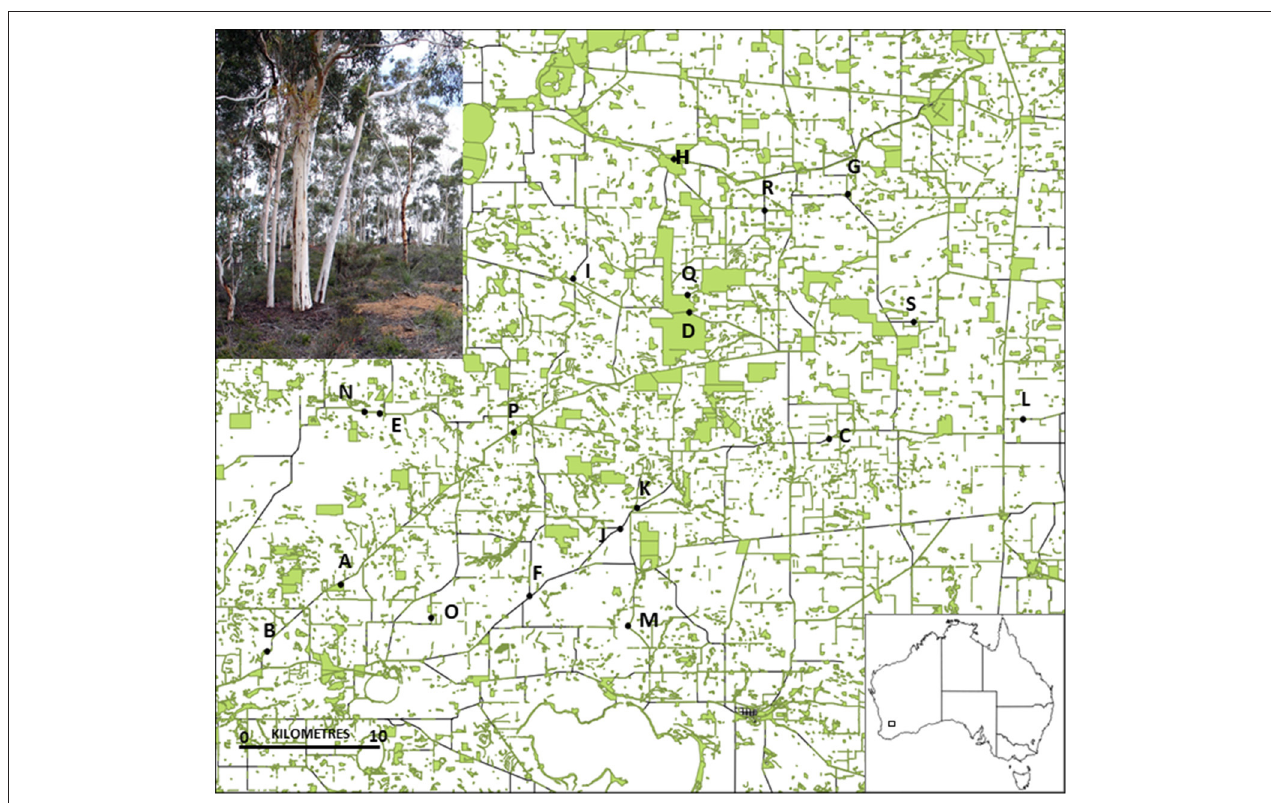
FIGURE 1 | Location of the 19 Eucalyptus wandoo study populations in south-western Australia, and (inset photo) an intact E. wandoo remnant. Remnant vegetation (shown in green) was surveyed for E. wandoo within the 50 50km study ×